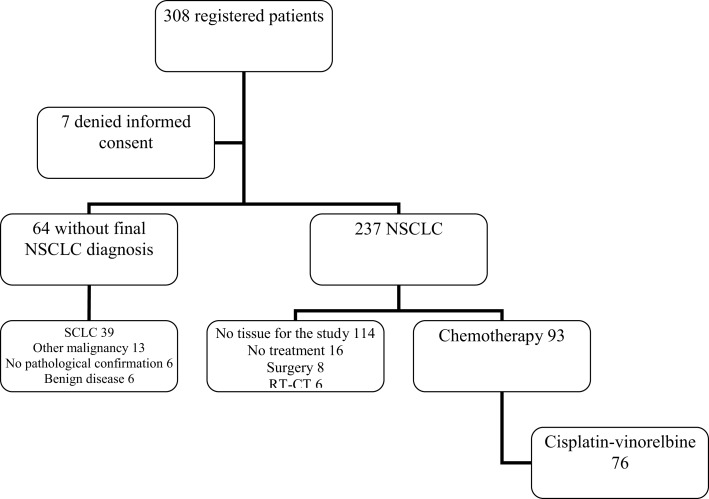
Flow chart of registered patients. NSCLC, non-small cell lung cancer; SCLC, small cell lung cancer; RT-CT, radiochemotherapy.